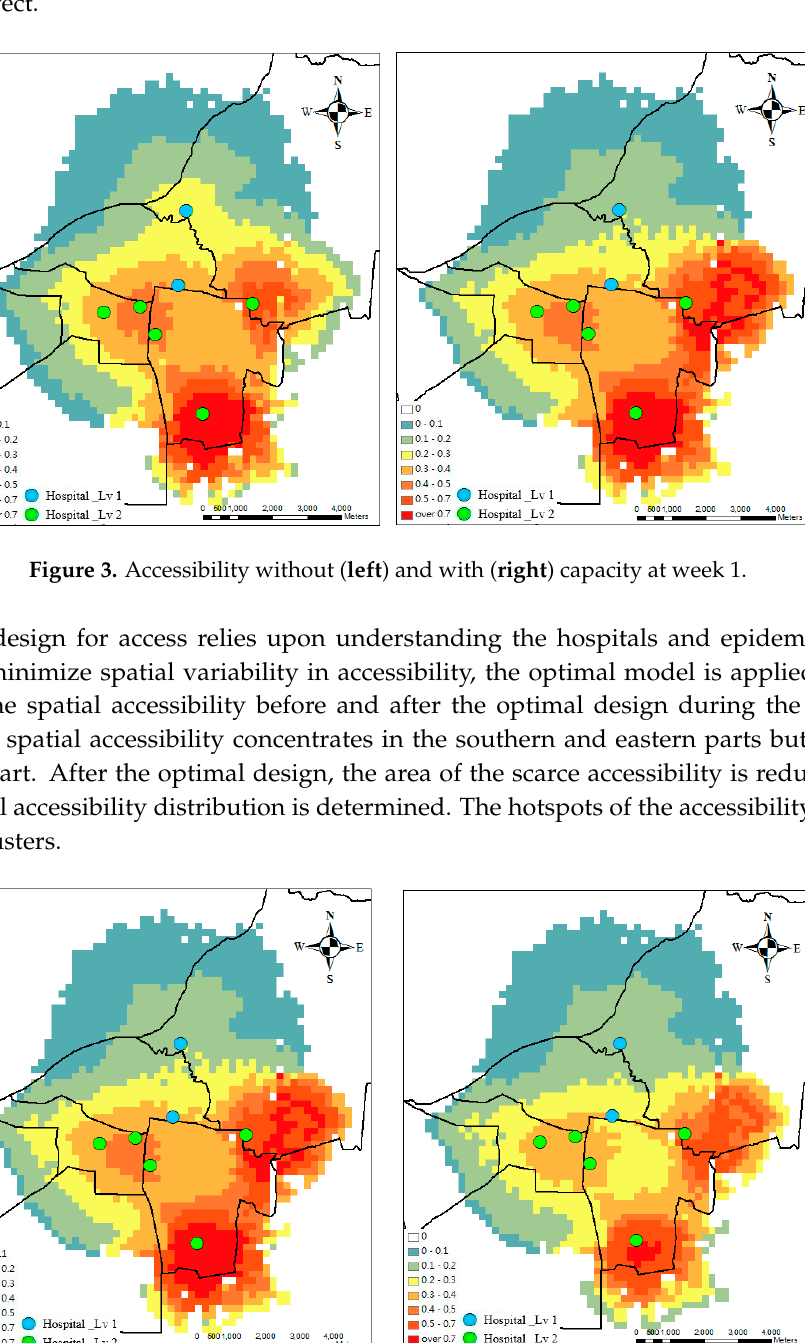
Figure 2. ( left ) Hospital network (level 1 (hospitals #4 and #5) indicates academic hospitals, and level 2 (hospitals #1, #2, #3, #6, and #7) means regional hospitals) and ( right ) patient patterns in